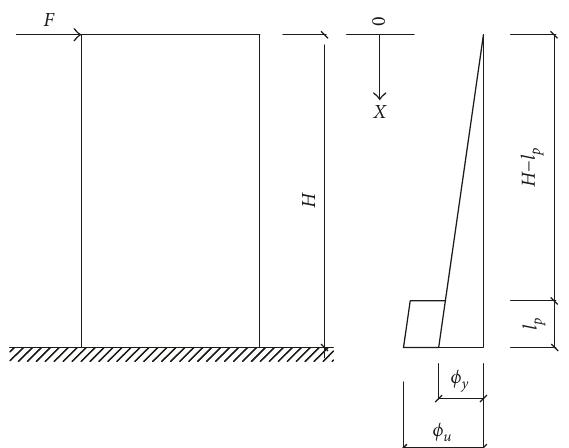
Figure 9: Curvature of cantilever shear